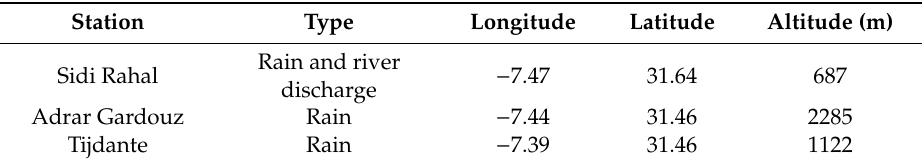
Table 1. Situation and period of measurement of hydro-rainfall stations. Station Type Longitude Latitude Altitude (m) Rain and river − 7.47 31.64 687 Sidi Rahal discharge Adrar Gardouz Rain − 7.44 31.46 2285 Tijdante Rain − 7.39 31.46